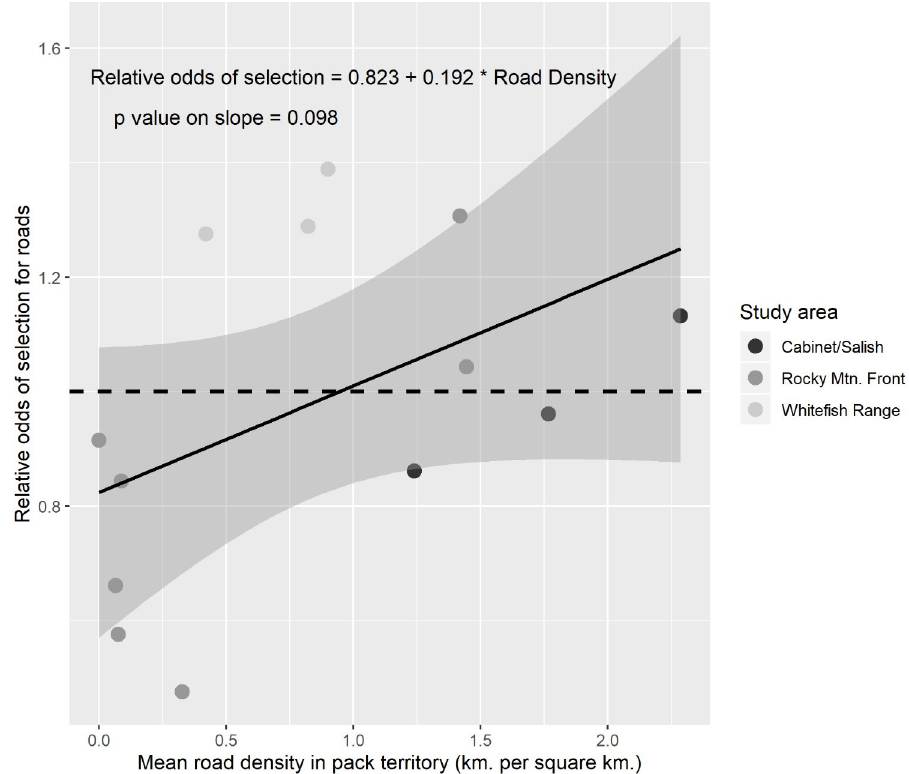
Fig 3. Relative odds of selection for roads by wolves. Relative odds of selection for road density by pack from mixed effects logistic regression model of within-territory resource selection by wolves, plotted against mean road density in each pack’s territory. Dashed line at y = 1 indicates neutral